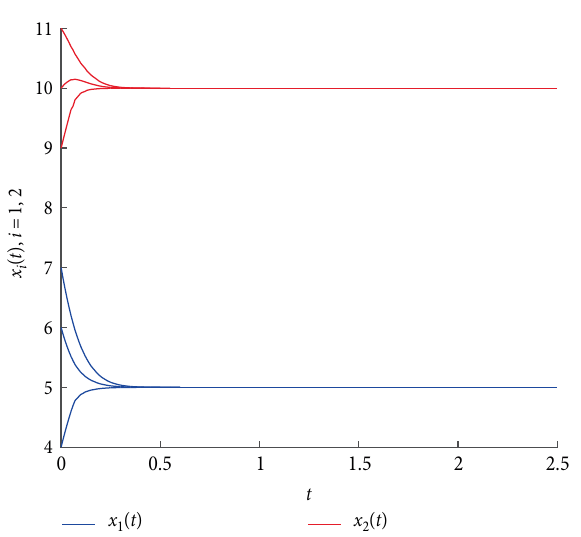
Figure 1: Numerical solution of Eq. (60) with different (𝑥 1 (𝑡), 𝑥 2 (𝑡)) initial values (𝑥 1 (𝑠), 𝑥 2 (𝑠)) ≡ (4,9), (6, 10), (7, 11), 𝑠 ∈ [−0.05,